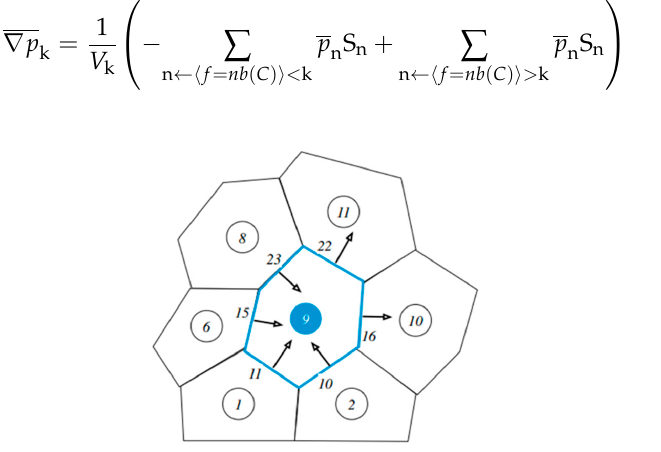
Figure 4. Element connectivity and face orientation using global indices.